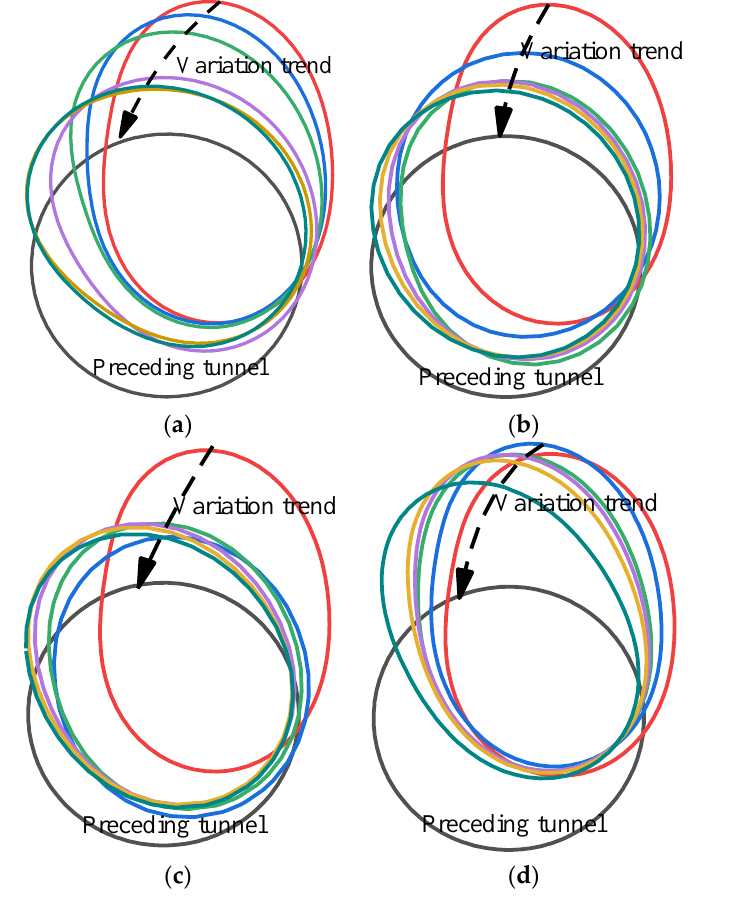
Figure 8. The shape of the preceding tunnel: ( a ) RR; ( b ) LR; ( c ) TR; ( d ) CR.